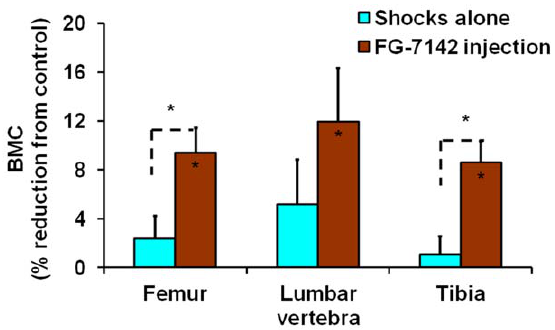
Figure 5. Reductions of BMC in specific bone sites at week 3 caused by electric shocks alone and electric shocks plus FG- 7142 injection. Values are means and S.E.M of percentage reductions compared to the control. The percentage reductions were calculated from body weight adjusted BMC values. The significance of each treatment compared to the control for each parameter is indicated by an asterisk for P , 0.05 inside the correspond- ing bar. The significance between two treatments is indicated by an asterisk for P , 0.05 above the corresponding bars.